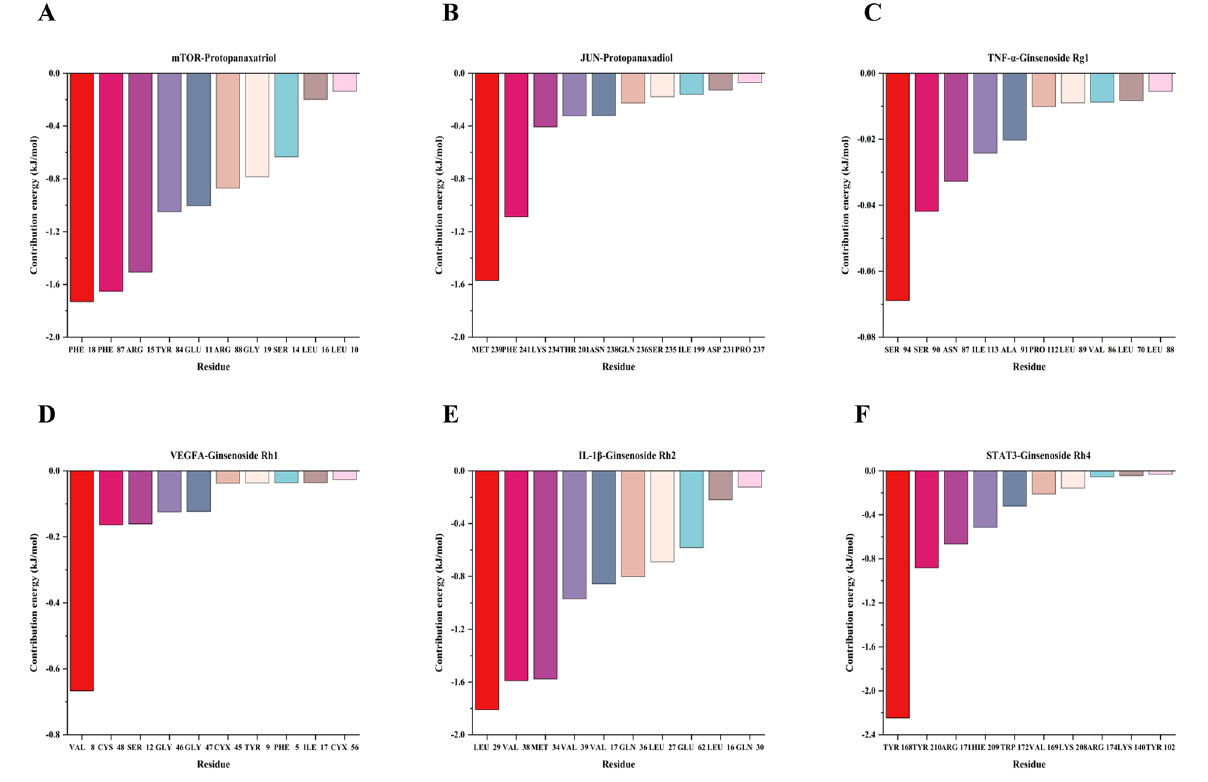
Figure 8. Active site information and contribution values of proteins in the process of protein-molecule binding during molecular dynamics